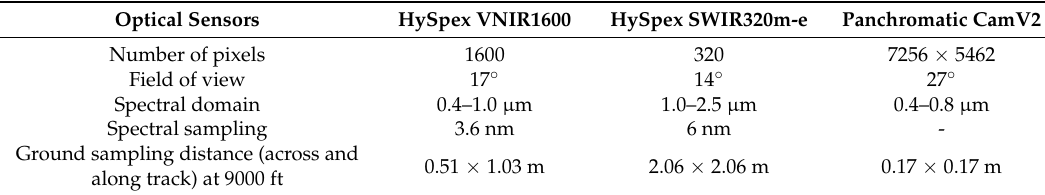
Table 2. Main parameters of optical sensors operated during the NOFO oil-on-water